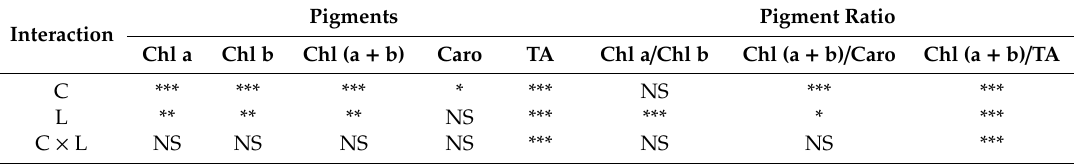
Table 4. The interaction e ff ects of cultivars and lightings on lettuce pigments. Interaction